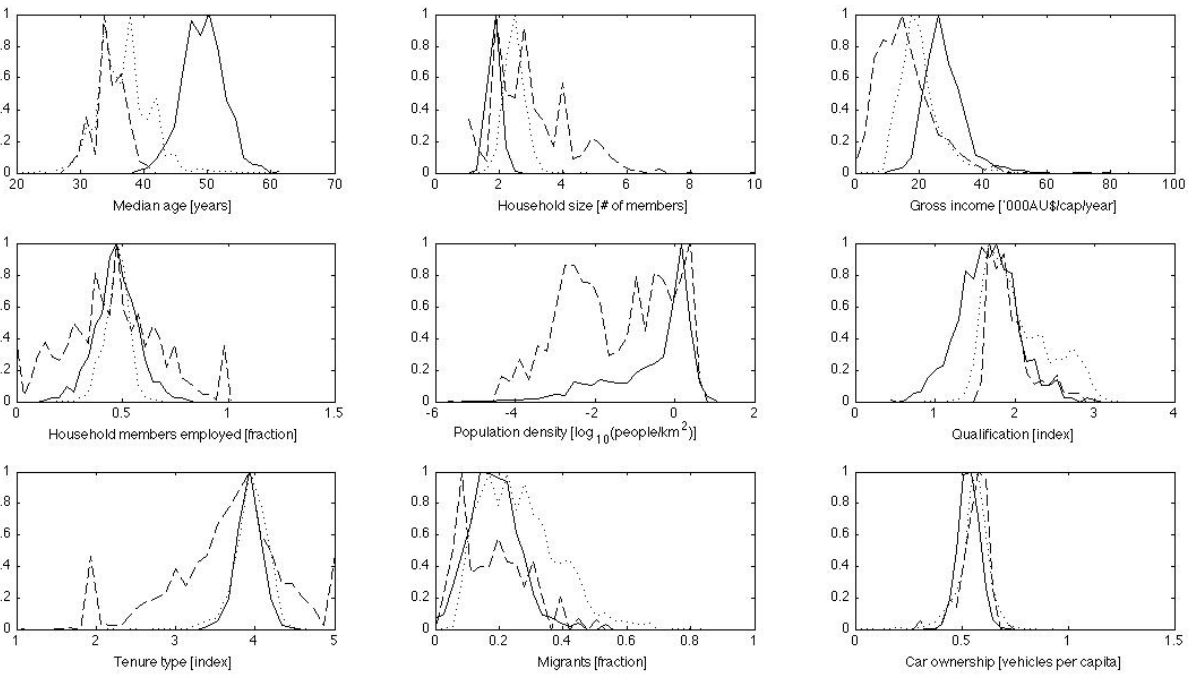
Figure 1. Normalised frequency distributions of explanatory variables (Australian Unity Wellbeing Surveys (AUWS) samples aggregated). Solid: AUWS, before filling in of missing data; dashed: Australian Household Expenditure Survey (HES); dotted: